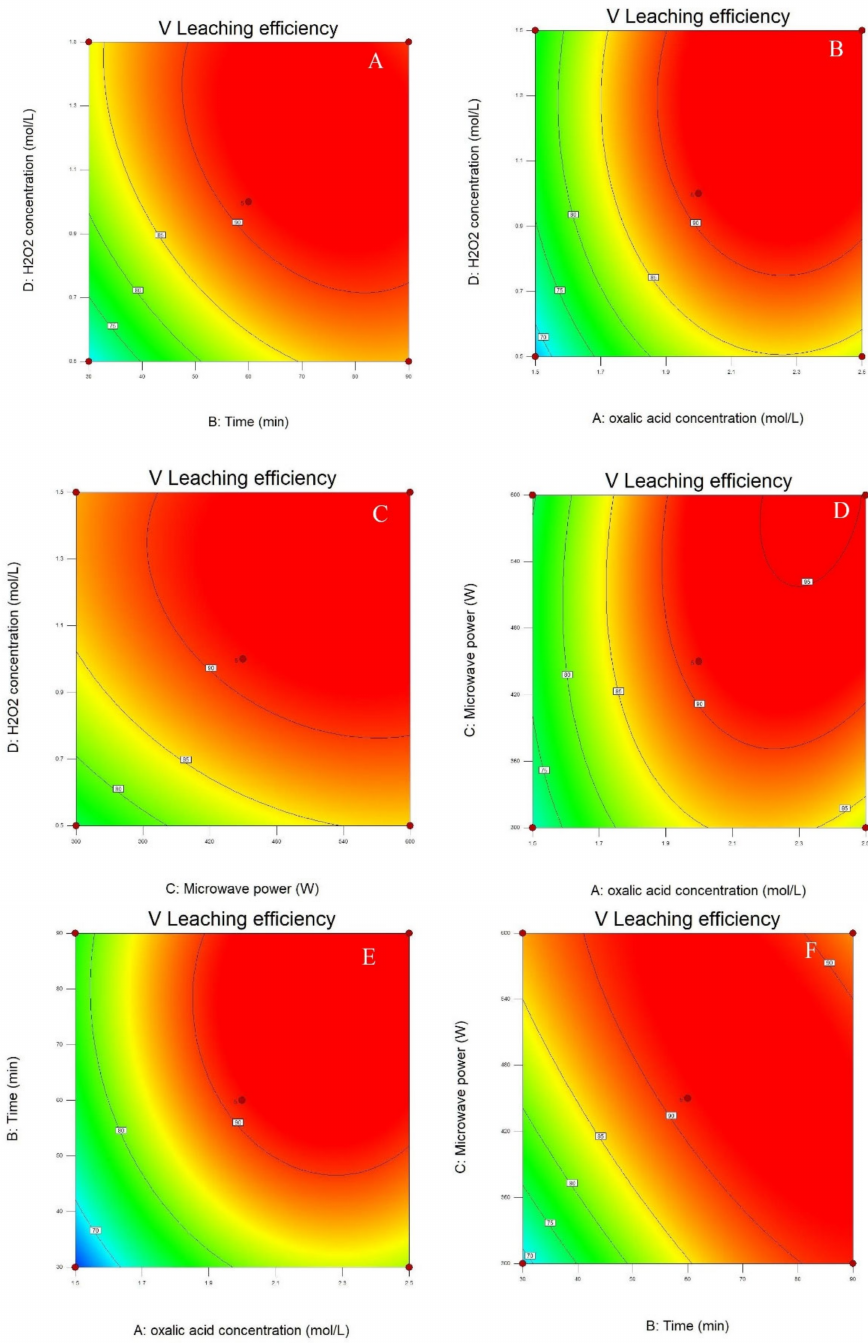
Figure 3. Contour plots of the effect of various parameters on V extraction: ( A ) Relationship of H 2 O 2 concentration and leaching time; ( B ) Relationship of H 2 O 2 concentration and C 2 H 2 O 4 concentra- tion; ( C ) Relationship of H 2 O 2 concentration and microwave power; ( D ) Relationship of C 2 H 2 O 4 concentration and microwave power; ( E ) Relationship of C 2 H 2 O 4 concentration and leaching time; ( F ) Relationship of leaching time and microwave